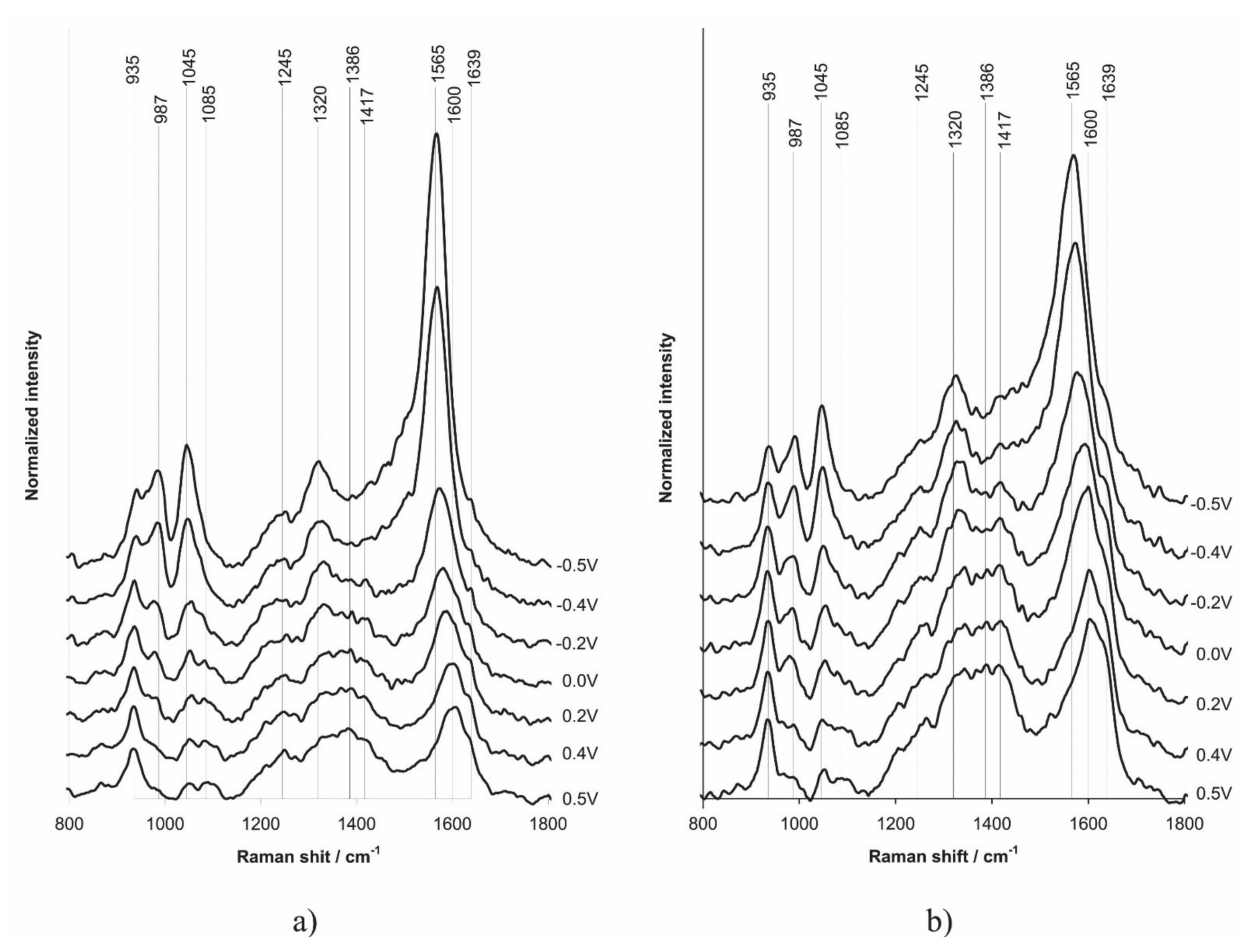
Figure 14. Normalized Raman spectra at 532 nm excitation for films of PPy complexes with PAMPSA ( a ), PAMPSNa ( b ), measured at fixed potentials in aqueous solution of 0.1 M NaClO 4 . Reprinted from Electrochimica Acta Volume 382, O.L. Gribkova et al., “Spectroelectrochemical investigation of electrodeposited polypyrrole complexes with sulfonated polyelectrolytes”, Pages No. 138307(1-14), Copyright 2021, with permission from Elsevier